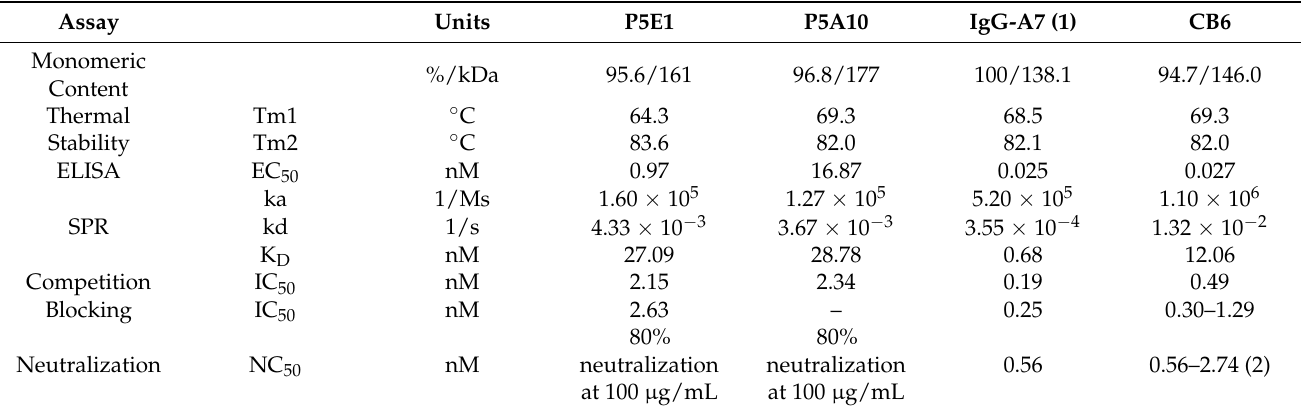
Figure 2. Authentic SARS-CoV-2 neutralization test of VH and VL optimized antibodies as compared to the parental antibody (P5E1-A6) and CB6. The table at the right of the plot reports the value of the neutralization potency of two assays performed in different days. The plot corresponds with Assay #1 dataset. Table 2. Summary of characterization of P5E1 and